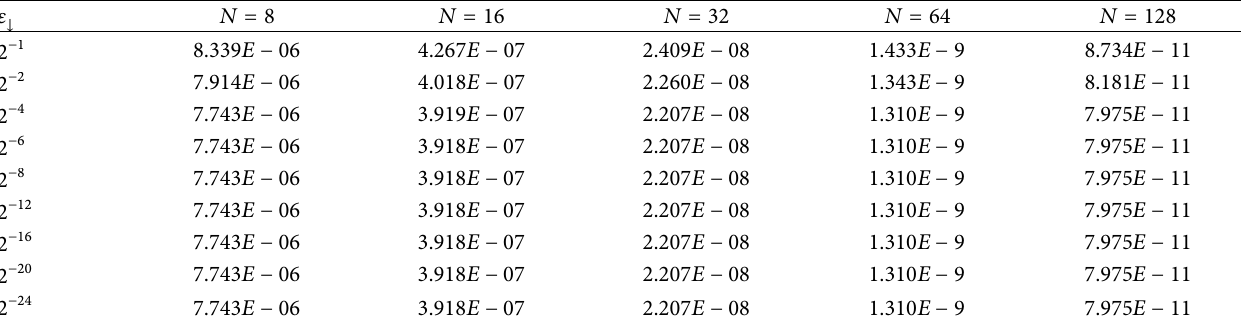
푁 , for the solution 휀,1 𝐷